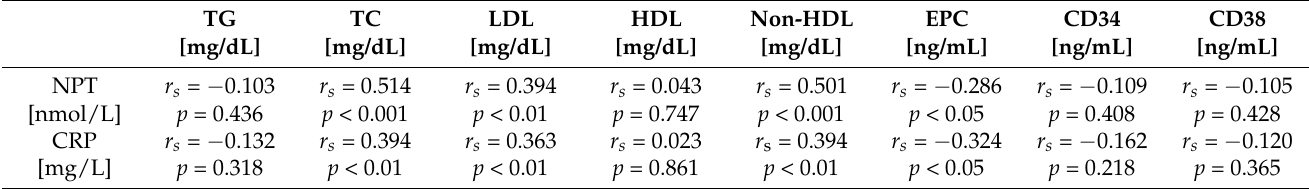
Table 4. Relationships between neopterin (NPT), C-reactive protein (CRP), ankle-brachial index (ABI), lipoprotein-lipid profile, and progenitor cells in patient with peripheral artery disease ( n = 59).